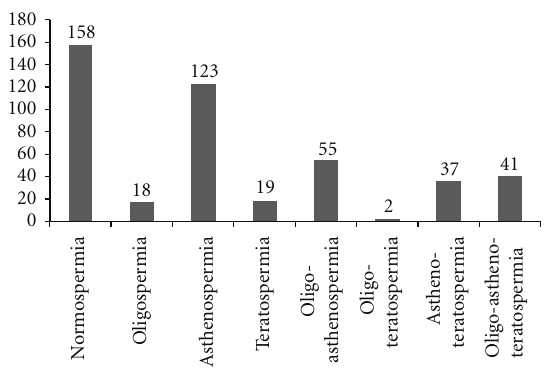
Figure 1: Classification of patients according to WHO reference parameters